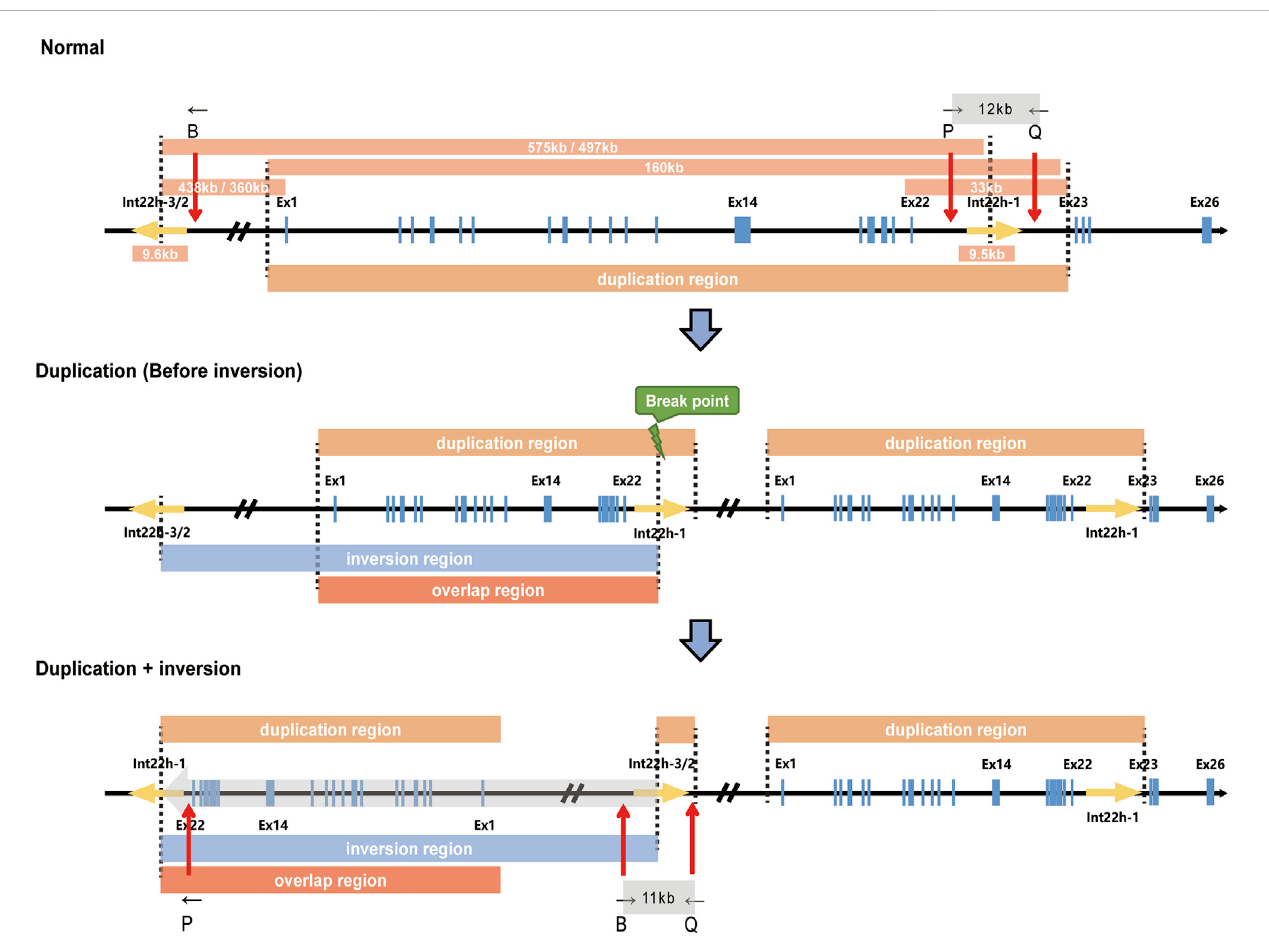
Schematic description of F8 duplication and inversion. The upper, middle, and lower panels represent the normal F8 , the duplication of F8 (in which inversion has not occurred yet), and the duplication and further inversion of F8 , respectively. The size of speci fi c regions, duplication regions, inversion regions,andregionsoverlappingduplicationandinversionareindicated.B,P,andQshowtherelativepositionsoftheprimersusedinInv22analysis.Ex1,Exon 1; Ex14, Exon 14; Ex22, Exon 22; Ex23, Exon 23; Ex26, Exon